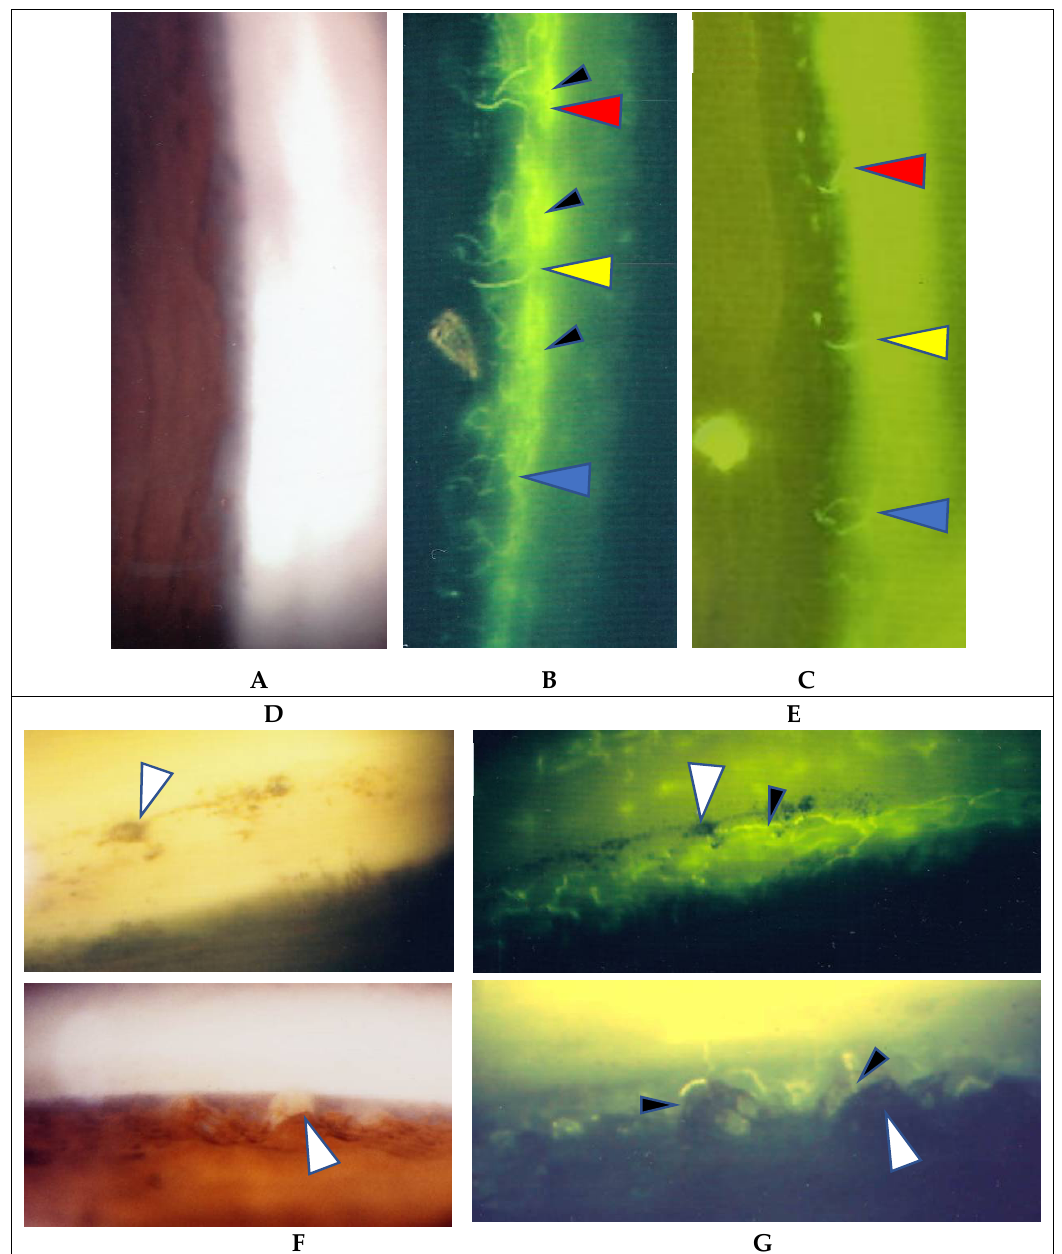
Figure 3. ( A – C ) Images of the right eye of Case 54, an 18-year-old male in Group III with a max IOP of 16 mmHg; ( D , E ) Images of the left eye of Case 4, a 52-year-old male in Group 1 with a max IOP of 31 mmHg; ( F , G ) Images of the right eye of Case 3, and 22-year-old male in Group 1 with a max IOP of 18 mmHg. Gonioscopy photographs taken ( A ) before and ( D ) after the start of topical betamethasone. Granuloma was not found prior the medication being applied ( A ). In Case 54 ( C ) and Case 4 ( E ), angle NV (ANV) remained at 0.8 and 1.6 years, respectively, after the start of a 3- to 4-times daily continuous topical betamethasone administration. In Case 4, IOP lowered from 31 to 14 mmHg ( E ) and the nodules disappeared ( D ) after the start of topical betamethasone, yet FGA clearly demonstrated ANV ( E ). Changes observed after the start of the topical betamethasone in both eyes were that the circumferential parts of ANV (small black arrow heads in B) almost disappeared ( C ) or showed no leakage of fluorescein die (small arrowheads in E ). Red, yellow, and blue arrowheads in B and C indicate the respective corresponding areas. In other cases, the circumferential areas of ANV were not visible due to being blocked by nodules (small arrowheads in F ) or being obscured by the trabecular meshwork. Large white arrowheads in D and E , and F and G indicate corresponding areas, respectively. No topical steroid was prescribed at the time of FGA ( G ).